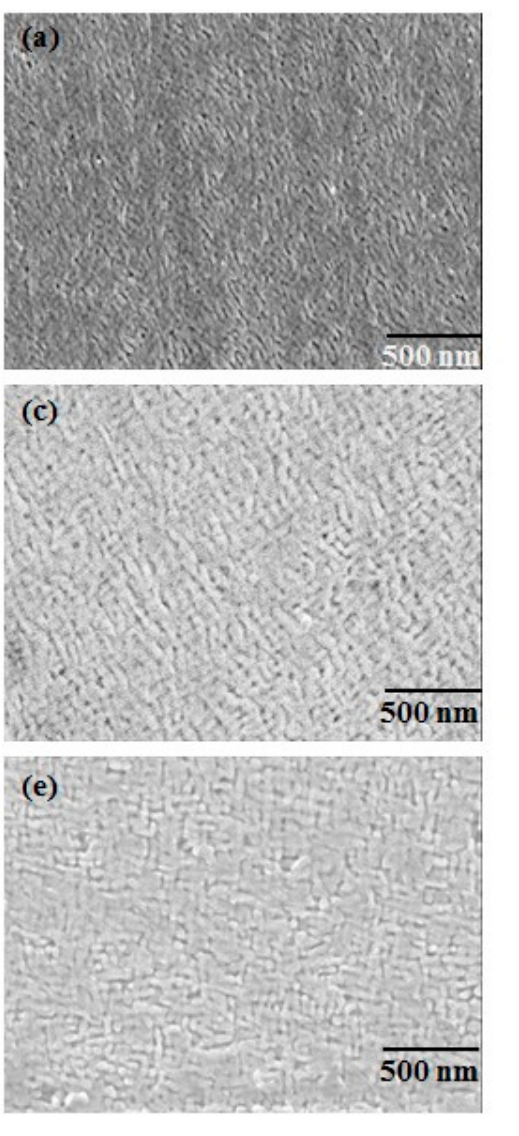
Figure 5. Field emission scanning electron microstructure showing spinodal phases with an α 1 -FM rod-like shape in the direction of the applied field embedded in the matrix of the α 2 -paramagnetic phase after complete heat treatment conditions: ( a ) Sample A; ( b ) amplified image of Sample A; ( c ) Sample B; ( d ) amplified image of Sample B; ( e ) Sample C; and ( f ) amplified image of Sample C.